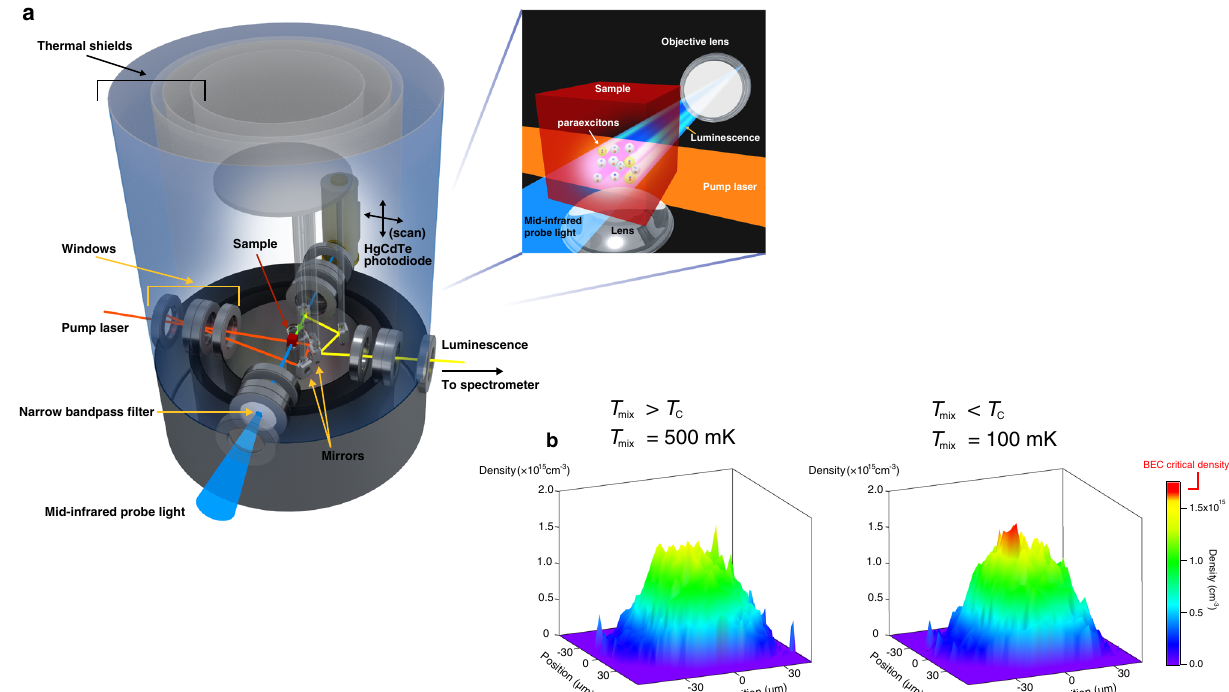
Fig. 1 | A novel setup for absorption imaging and appearance of the con- densate. a Experimental setup inside the cryogen-free dilution refrigerator, showing the optical paths of the pump laser (orange solid line), luminescence (yellow solid line), mid-infra-red probe light (blue solid line), and location of the sample material (red cube). The optical components (mirrors and mirror holders), thermal shields (blue and grey cylinders), windows, narrow bandpass fi lters, and a nitrogen-cooled HgCdTe photodiode (beige cylinder) are also labelled. We mea- suredthespatiallyresolveddifferentialtransmissionthatwastheabsorptionimage usingthephotodiodesetonatranslation-motorizedstageforscanning.Thespatial resolution of the imaging system was 7.8 μ m (FWHM). (upper right panel) Sche- maticillustrationofthephysicalprocessesinvolvedforparaexcitonsinthesample: excitation, luminescence, and absorption. The excitation beam (orange solid line)